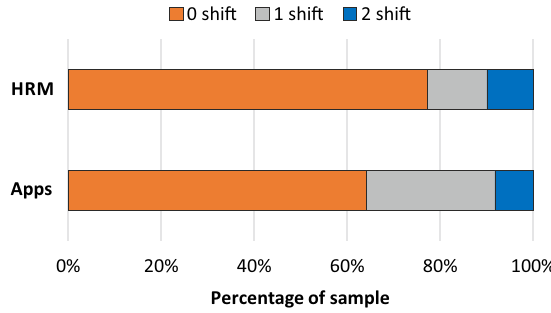
Figure 1. Proportion of shift for physical activity tracker items. HRM = heart rate monitor or sports